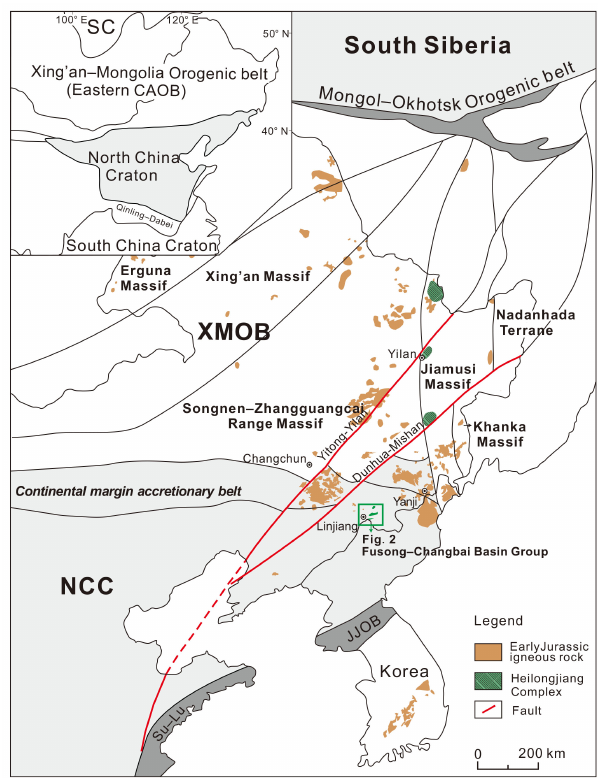
Figure 1. Geological sketch map of the northeastern North China Craton. JJOB: Jing–Ji Orogenic